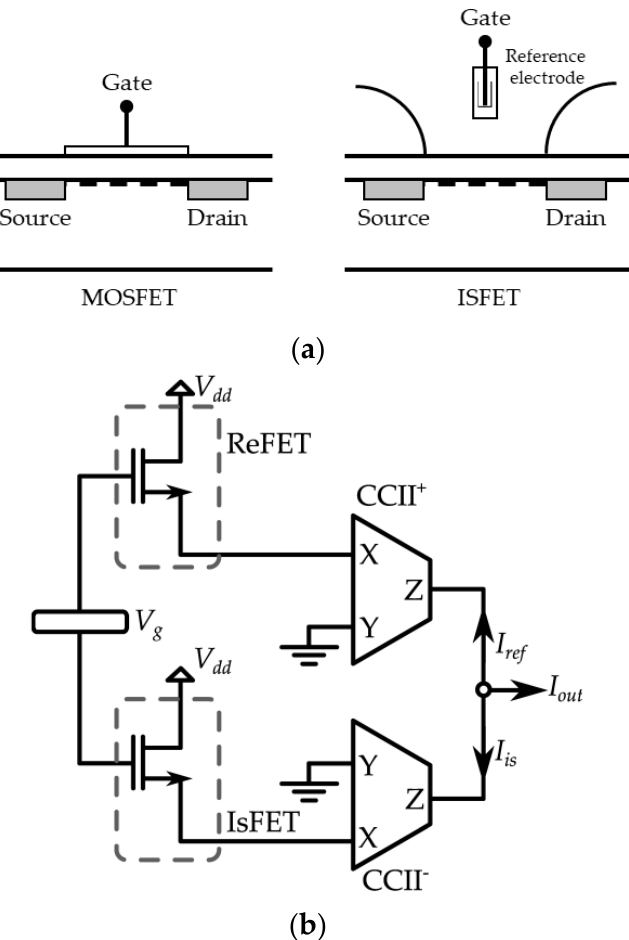
Figure 12. ( a ) Comparison of ISFET and MOSFET; ( b ) standard differential current-mode approach.